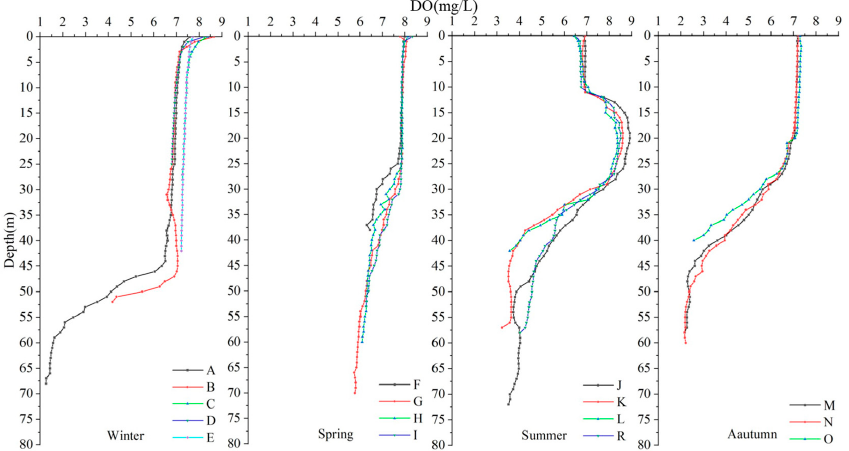
Figure 4. Seasonal variations of vertical dissolved oxygen (DO) section in Lake